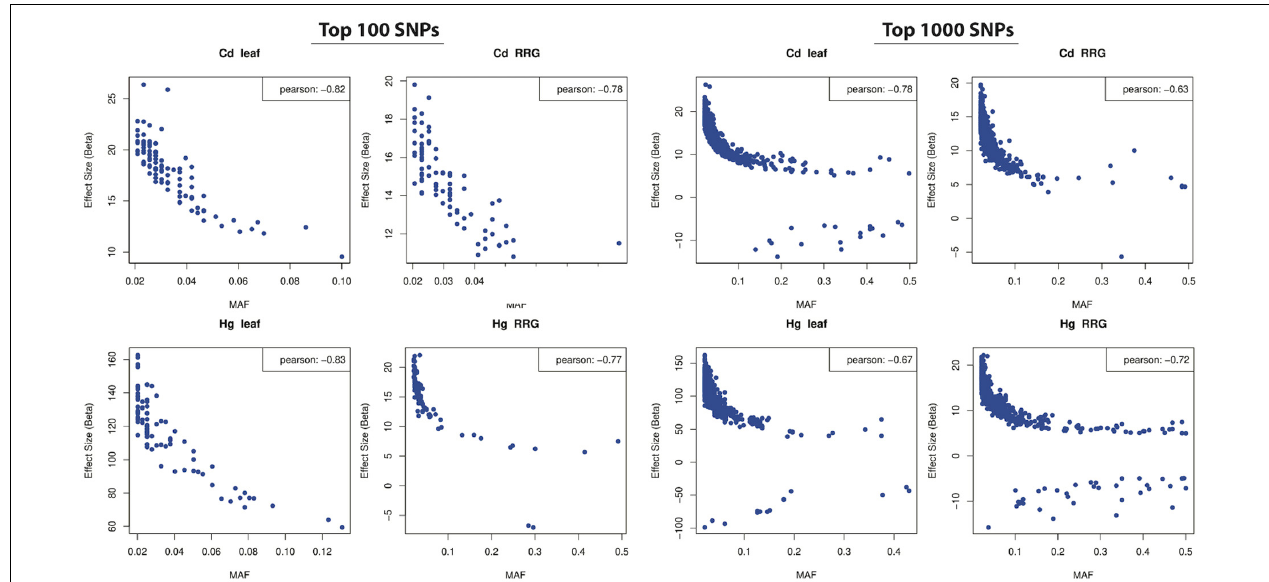
FIGURE 7 | Correlations between minor allele frequency (MAF; x -axis) and SNP effect size ( y -axis) in the top 100 (left four panels) and top 1000 (right four panels) most significant SNPs (effect sizes estimated from GAPIT). Pearson’s correlation coefficients shown in upper right corners.